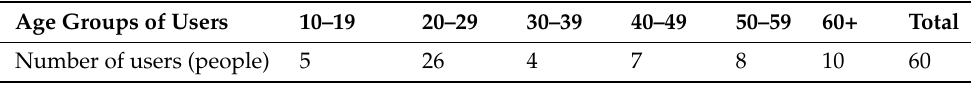
Table 1. Breakdown of system users and questionnaire survey